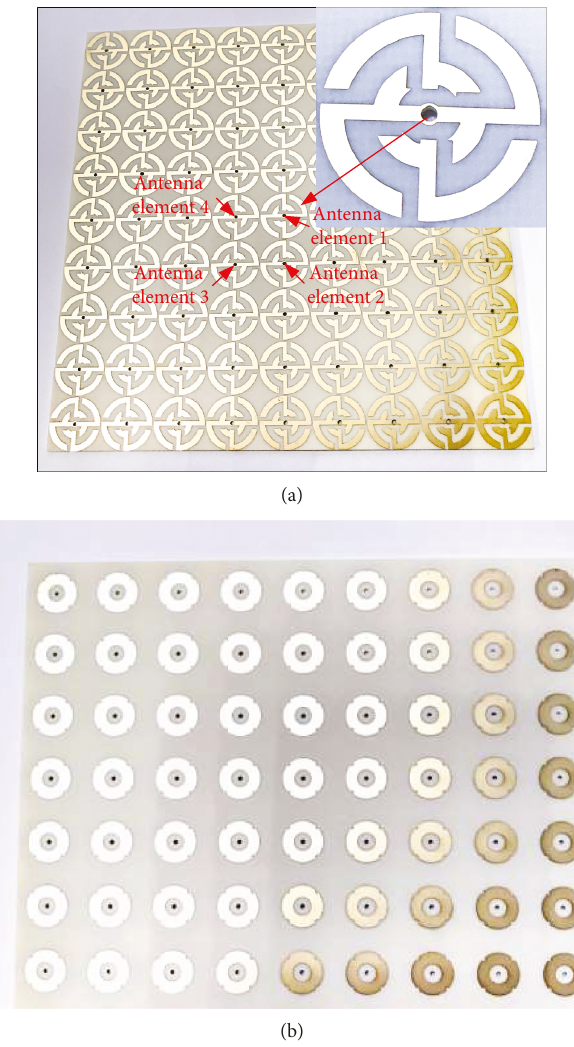
Figure 8: Top (a) and bottom (b) view of the fabricated 9 × 9 MIMO antenna